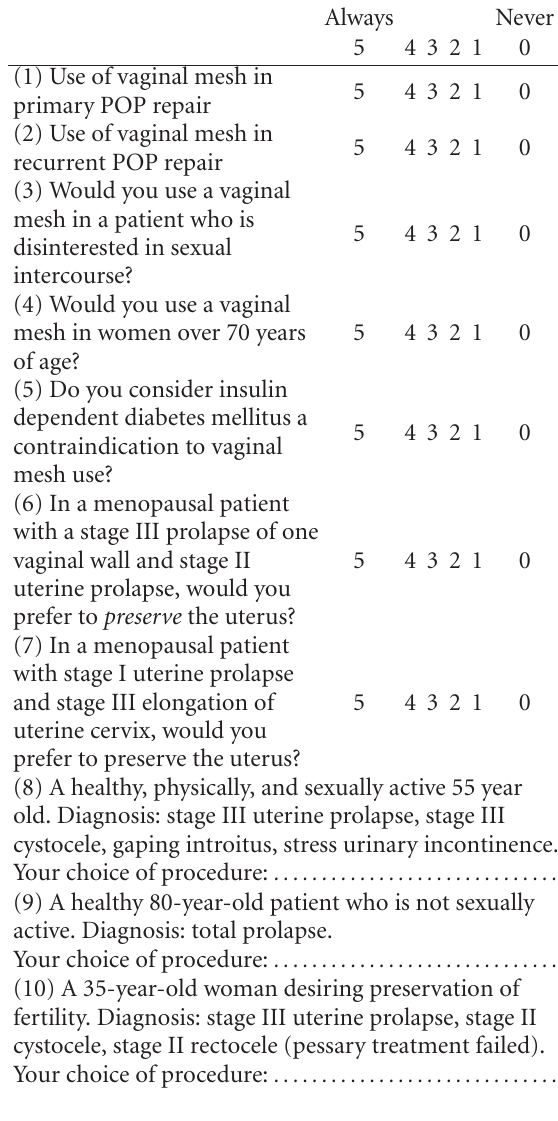
fertility. Diagnosis: stage III uterine prolapse, stage II cystocele, stage II rectocele (pessary treatment